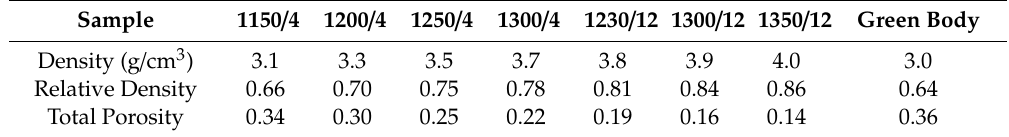
Table 3. Substrate densities for di ff erent processing times and